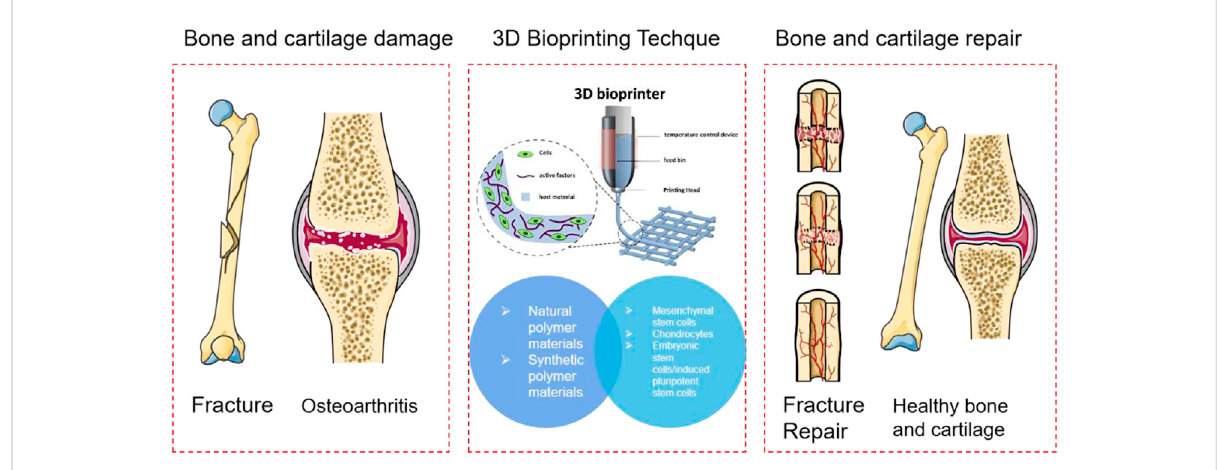
FIGURE 1 Schematic diagram of bone and cartilage using 3D bio printing based on polymer